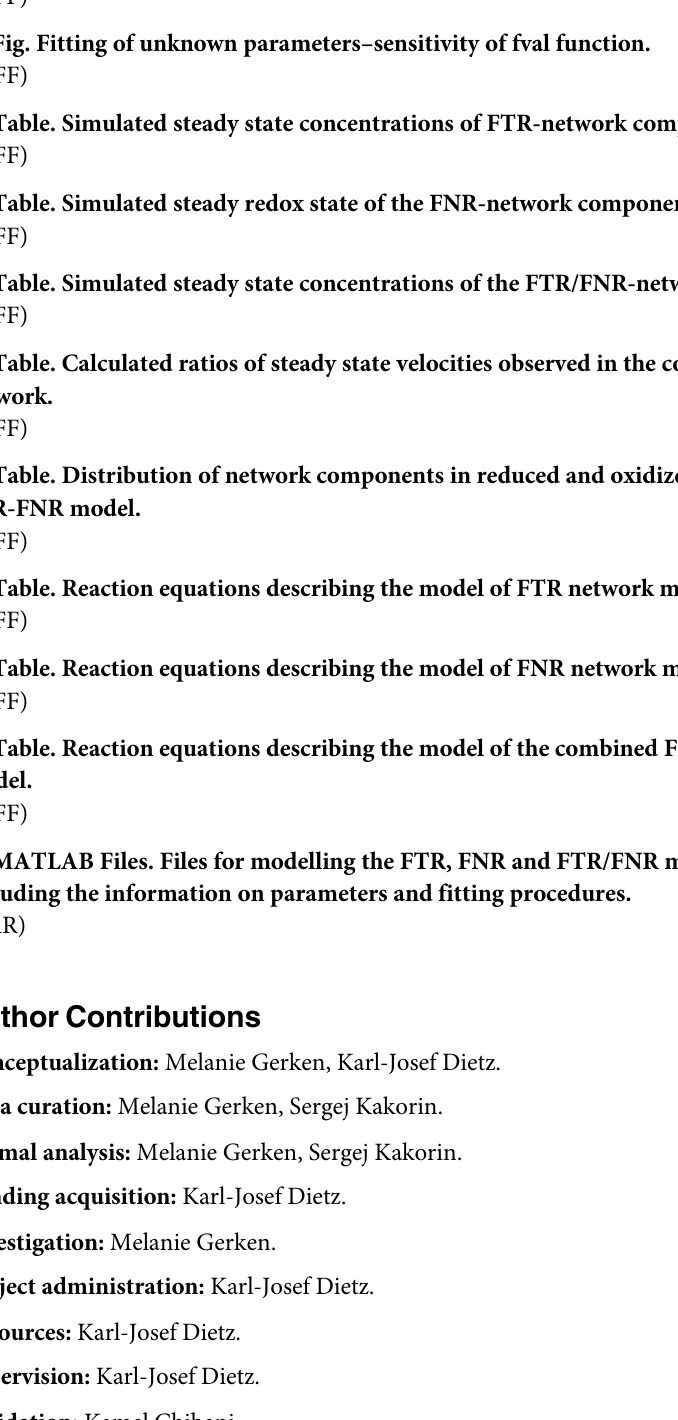
S5 Fig. Fitting of unknown parameter—Results. (TIFF) S6 Fig. Fitting of unknown parameters–sensitivity of fval function. (TIFF) S1 Table. Simulated steady state concentrations of FTR-network components. (TIFF) S2 Table. Simulated steady redox state of the FNR-network components. (TIFF) S3 Table. Simulated steady state concentrations of the FTR/FNR-network components. (TIFF) S4 Table. Calculated ratios of steady state velocities observed in the combined FTR/FNR- network. (TIFF) S5 Table. Distribution of network components in reduced and oxidized form at t = 0 in FTR-FNR model. S6 Table. Reaction equations describing the model of FTR network model. (TIFF) S7 Table. Reaction equations describing the model of FNR network model. (TIFF) S8 Table. Reaction equations describing the model of the combined FTR-FNR network